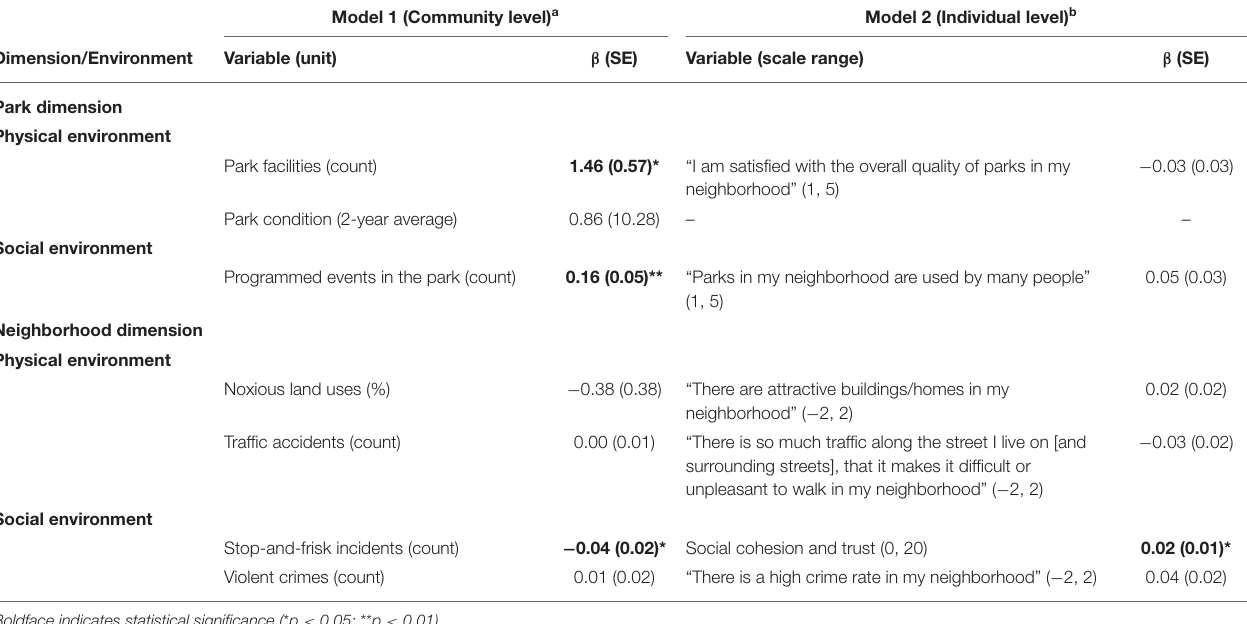
TABLE 4 | Park use regressed on environmental variables at the community level (Model 1) and individual level (Model